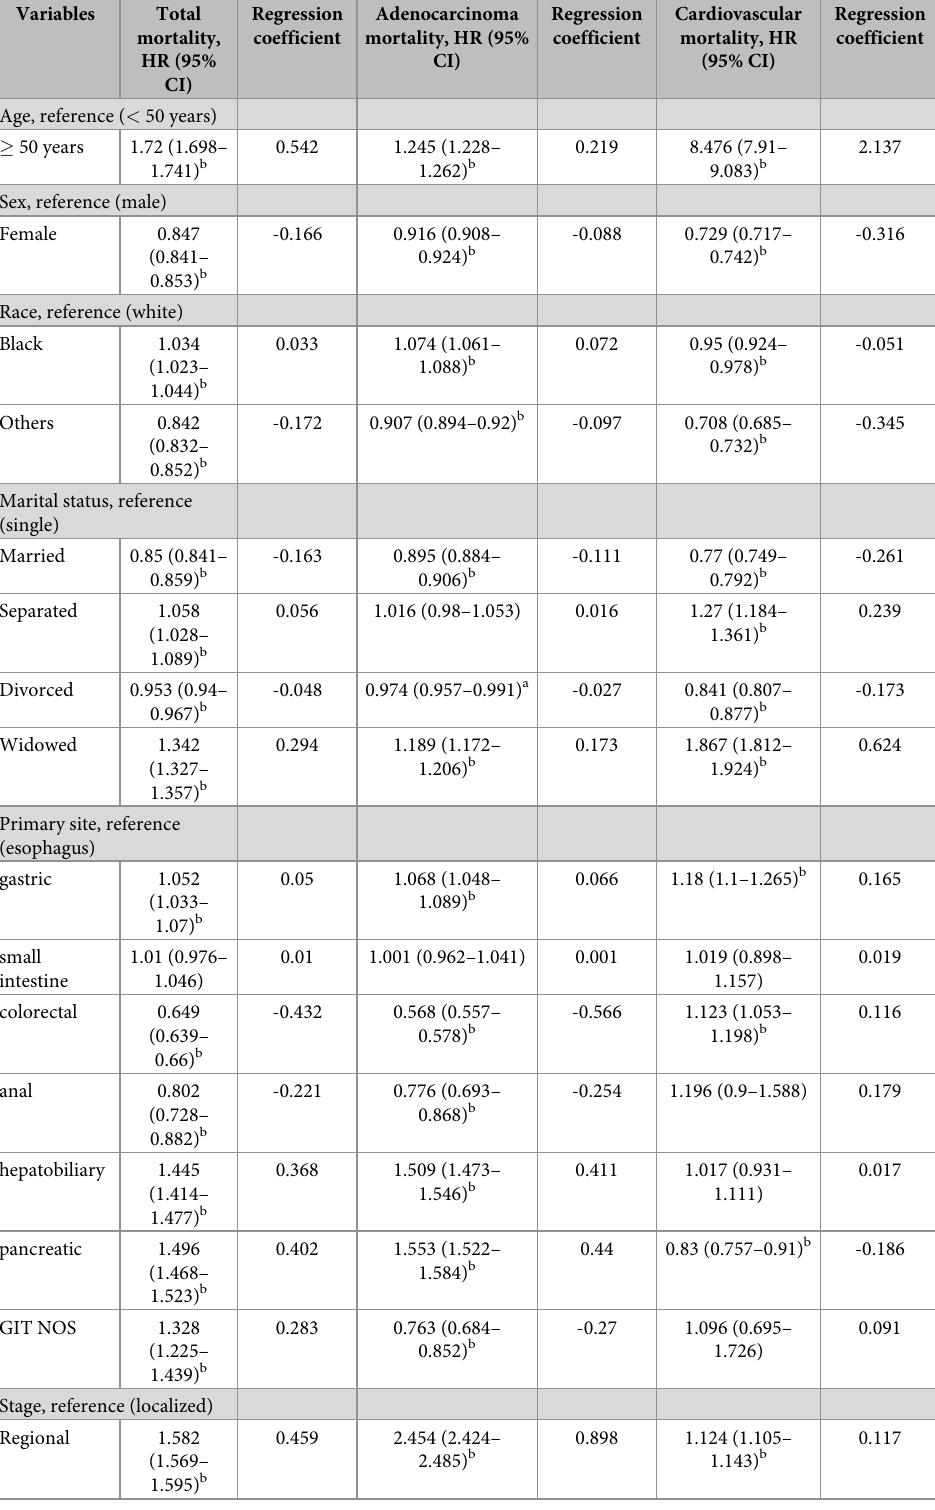
Table 3. Multivariate analysis using Cox regression